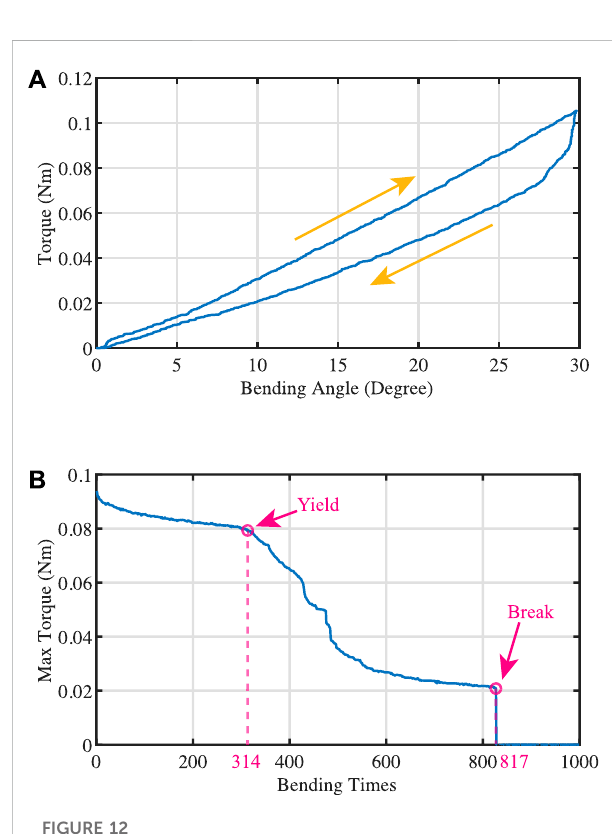
FIGURE 12 Experiment results of 1-mm thick ABS printed kirigami-inspired spring with pattern Single-Column-Flat-4mm . (A) Bending stiffness test results; (B) Endurance test